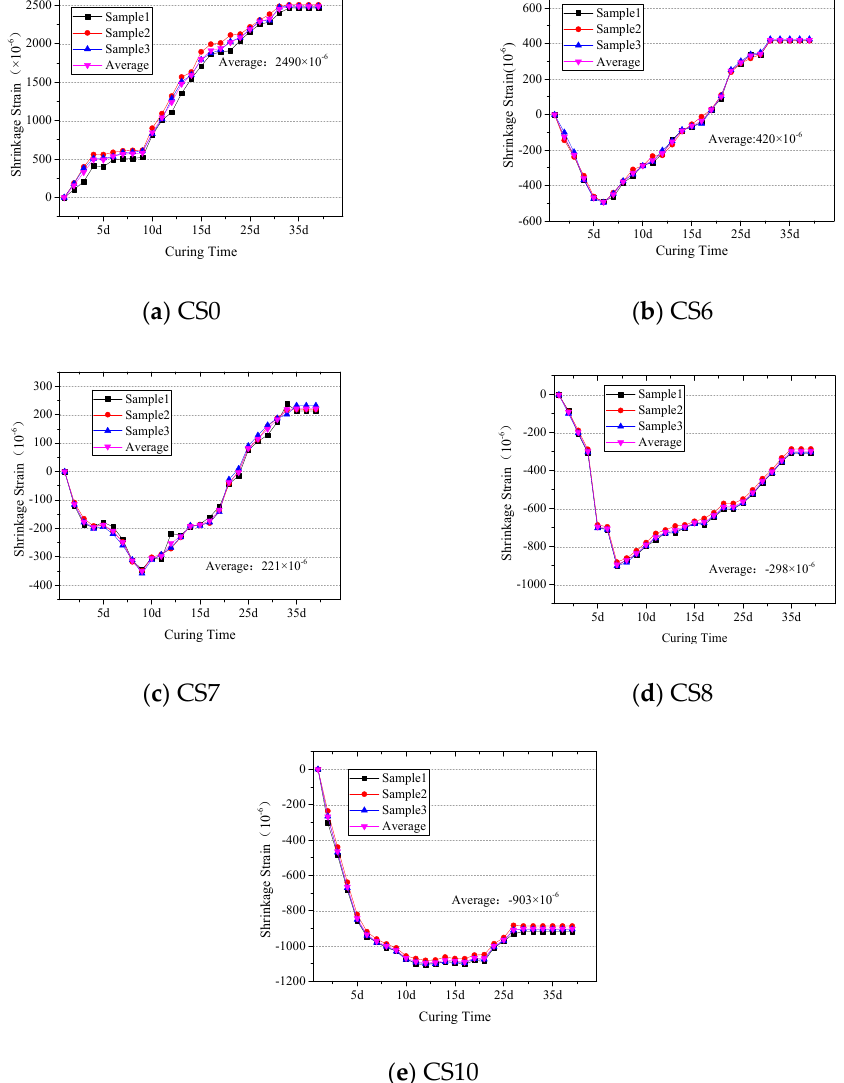
Figure 8. The shrinkage strain of CS0, CS6, CS7, CS8, CS10 ( a – e ,respectively) Table 4. The shrinkage strain, average value of shrinkage strain, and coefficient of variation for the samples on the 40th day of the test.